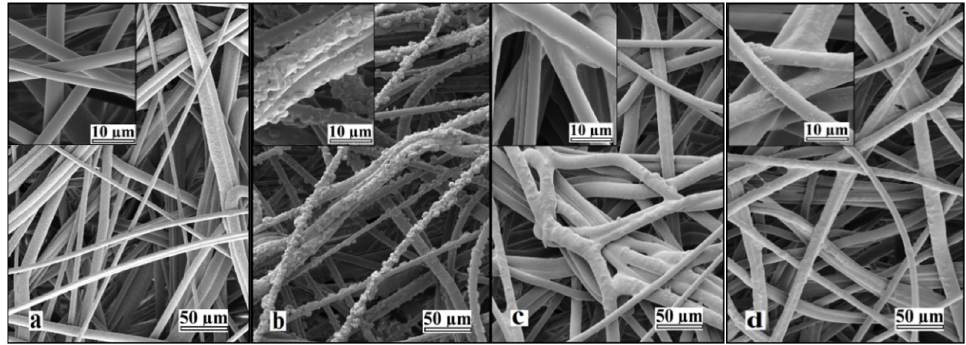
Figure 3. Representative SEM images of nonwoven PBT membranes: ( a ) non-grafted PBT, ( b ) UV- grafted PBT-GMA (20% weight gain), ( c ) cation exchanger PBT-GMA-SO 3 , and ( d ) anion exchanger PBT-GMA-DEA. The insets show higher magnification images.